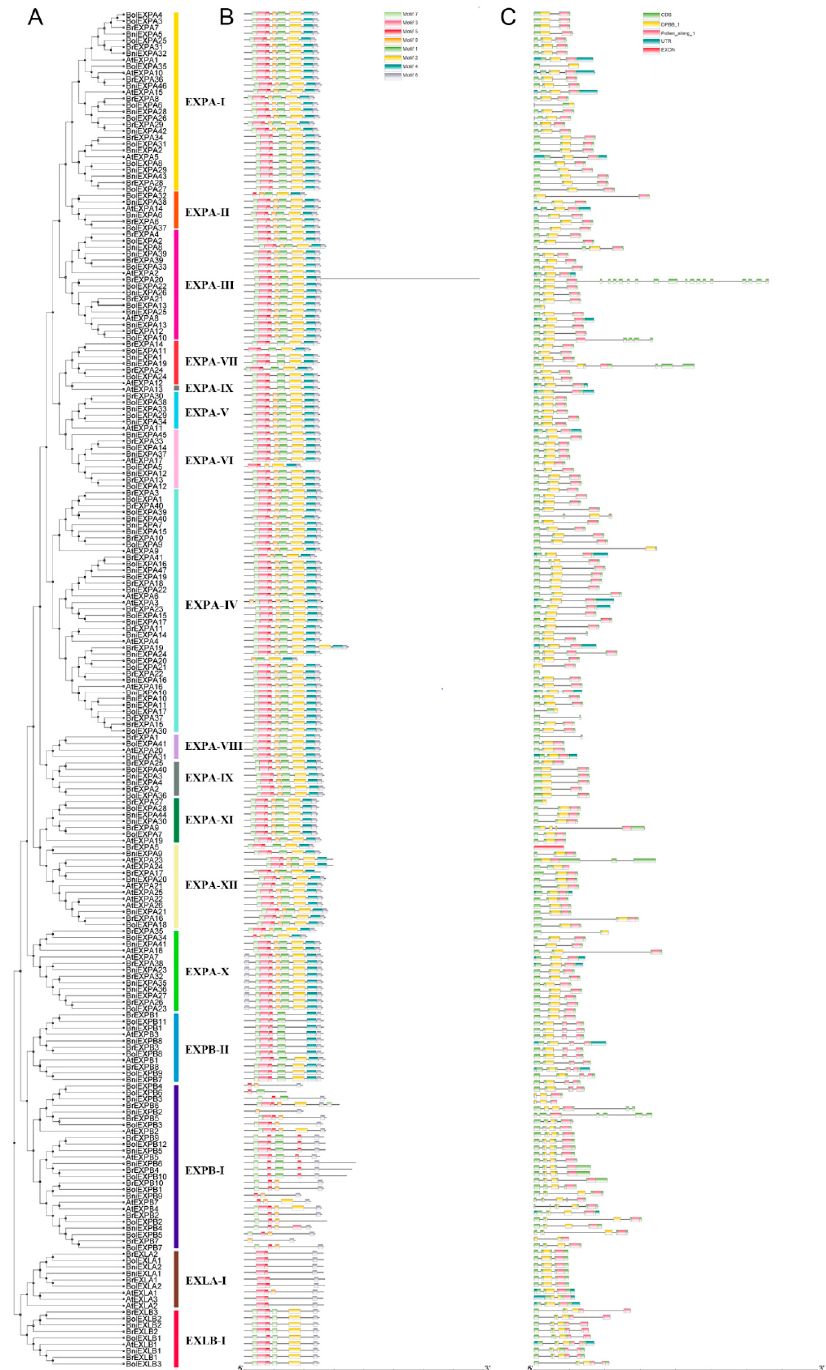
Figure 3. Phylogenetic relationships and classification of subgroups ( A ), conserved motifs analyses ( B ), gene structure and domain distribution ( C ) of expansin genes in A. thaliana , B. rapa , B. oleracea , and B. nigra . The phylogenetic tree constructed with MEGA 6.0, di ff erent subgroups were marked by bars with di ff erent colors. The motif compositions were detected with an online tool, MEME, which 8 di ff erent colored boxes were found in expansin genes. Di ff erent gene structures and domain distribution were represented by di ff erent colored boxes whereas introns were shown in gray lines. The scale underneath was to measure amino acids ( B ) or nucleotides lengths ( C